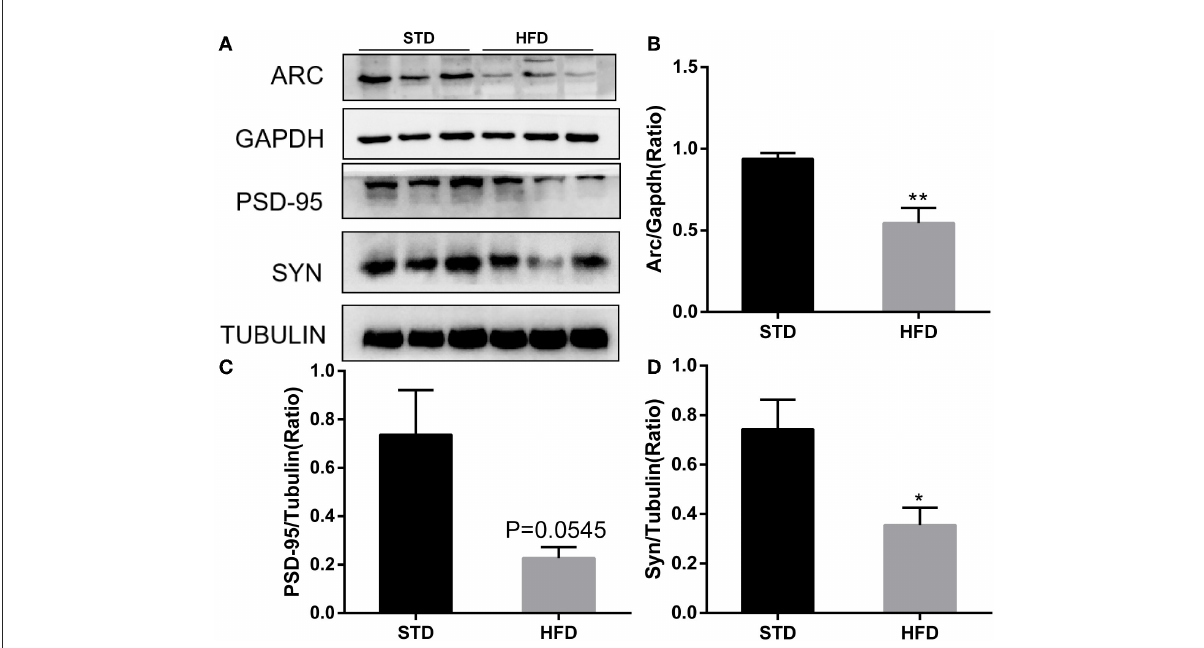
FIGURE8 Western blot analyses of ARC, PSD-95, and SYN in hippocampal regions. (A) The band of western blot for ARC, PSD-95, and SYN. (B–D) Densitometric data of ARC, PSD-95, and SYN expression using ImageJ are presented as the means ± SEM of three independent experiments, n = 3, 3. * P < 0.05; ** P <